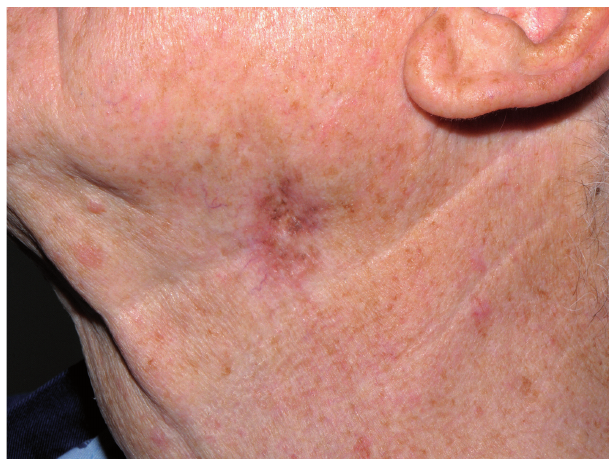
Figure 1. Lesion on left side of neck.